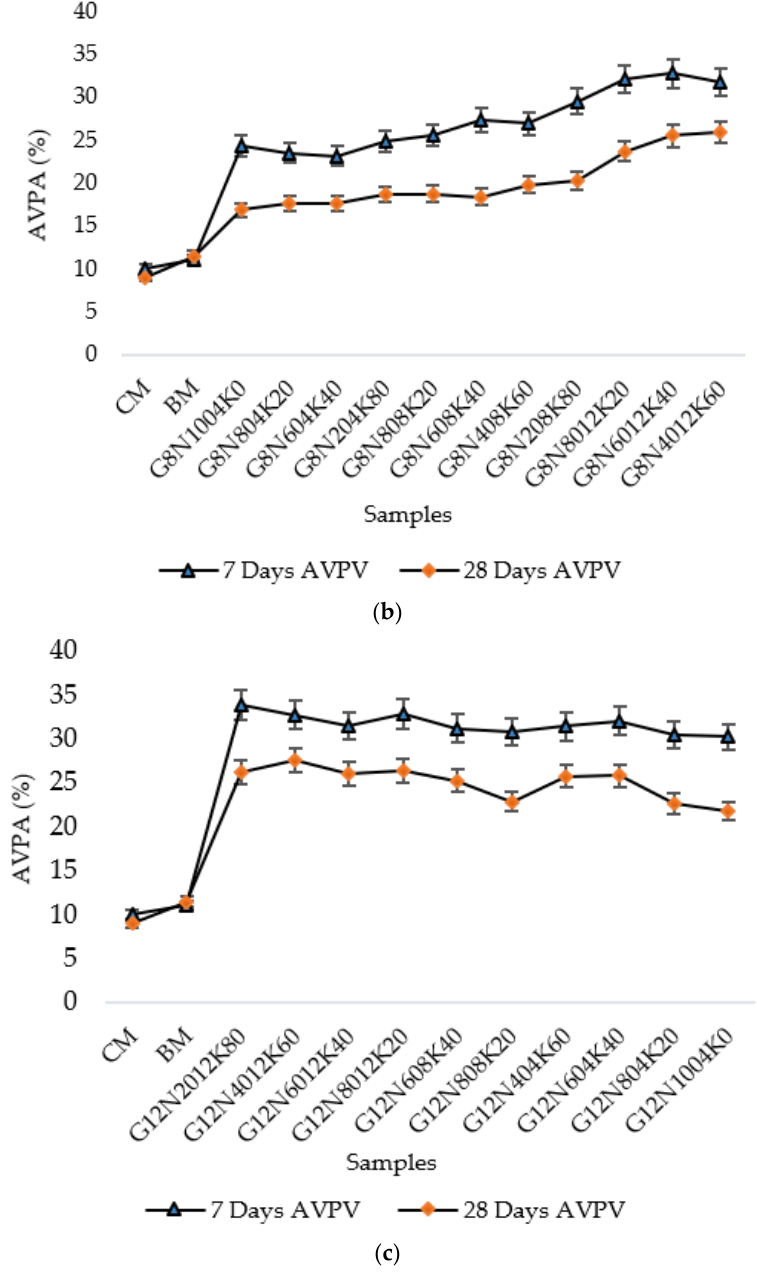
Figure 7. Apparent volume of permeable voids (AVPV) of geopolymer cement pastes: ( a ) for 4 M samples, ( b ) for 8 M samples, and ( c ) for 12 M samples.